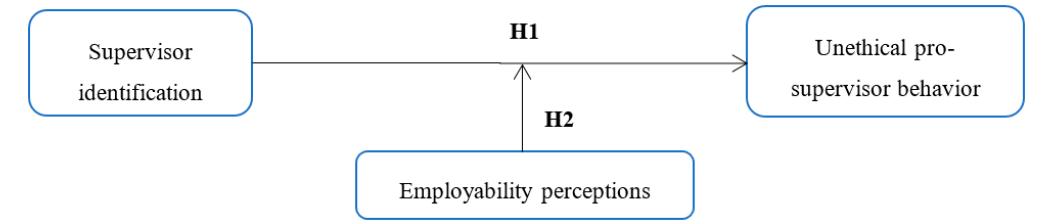
Figure 1. Hypothesized model.